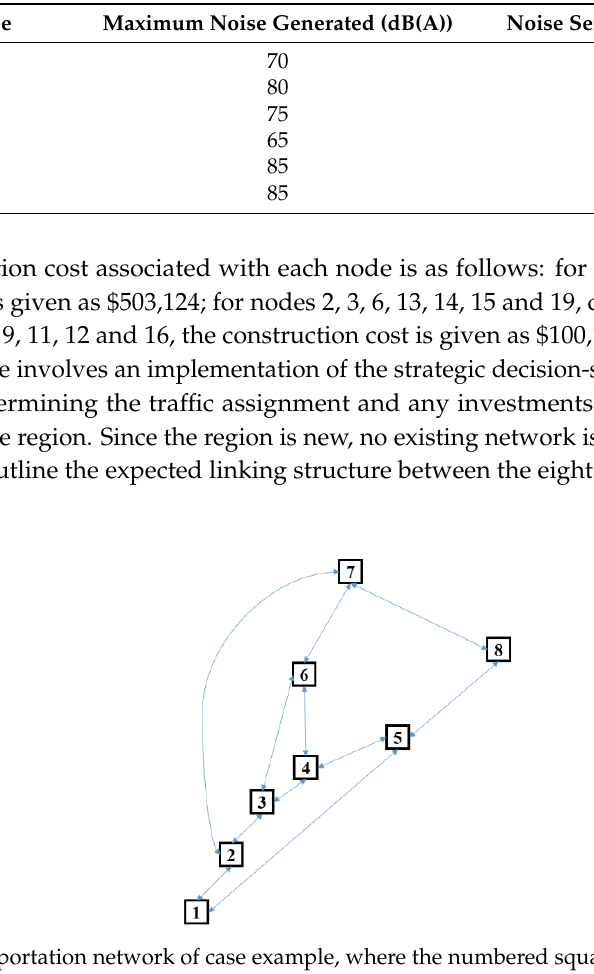
Table 2. Building type and associated noise characteristics.